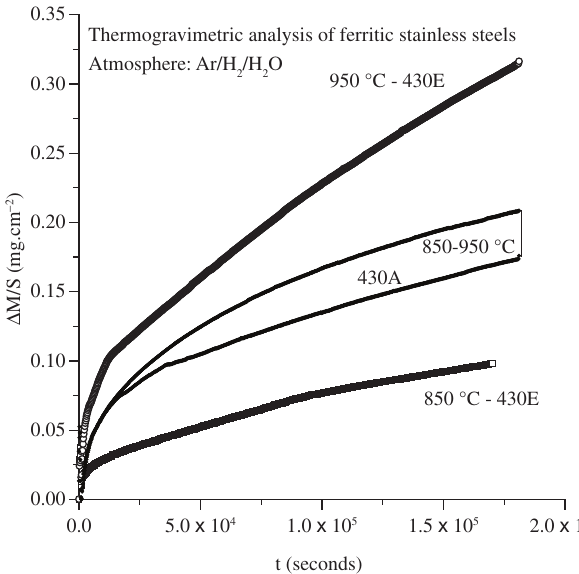
Figure 6. Comparison of the mass gains as a function of time for the 430A and 430E steels oxidized at 850, 900 and 950 o C in Ar/H